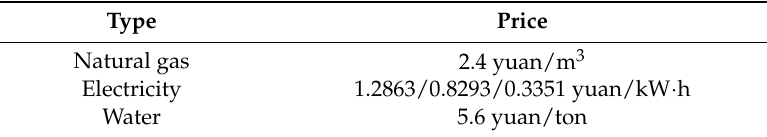
Table 2. System auxiliary material prices.